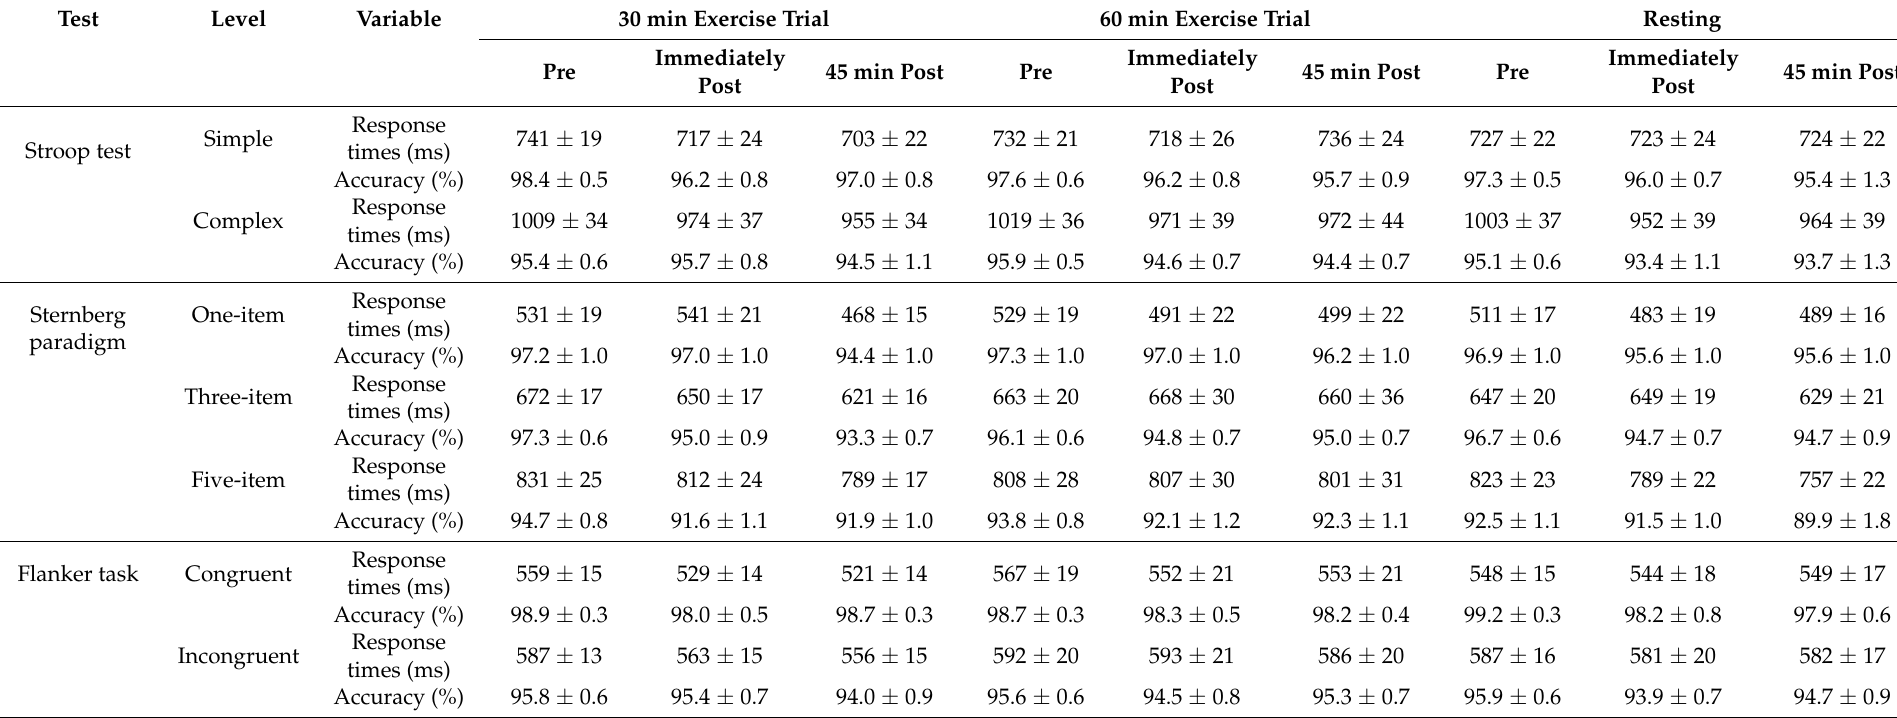
Table 2. Cognitive function data across the morning on the 30 min exercise, 60 min exercise, and resting control trials. Data are mean ±